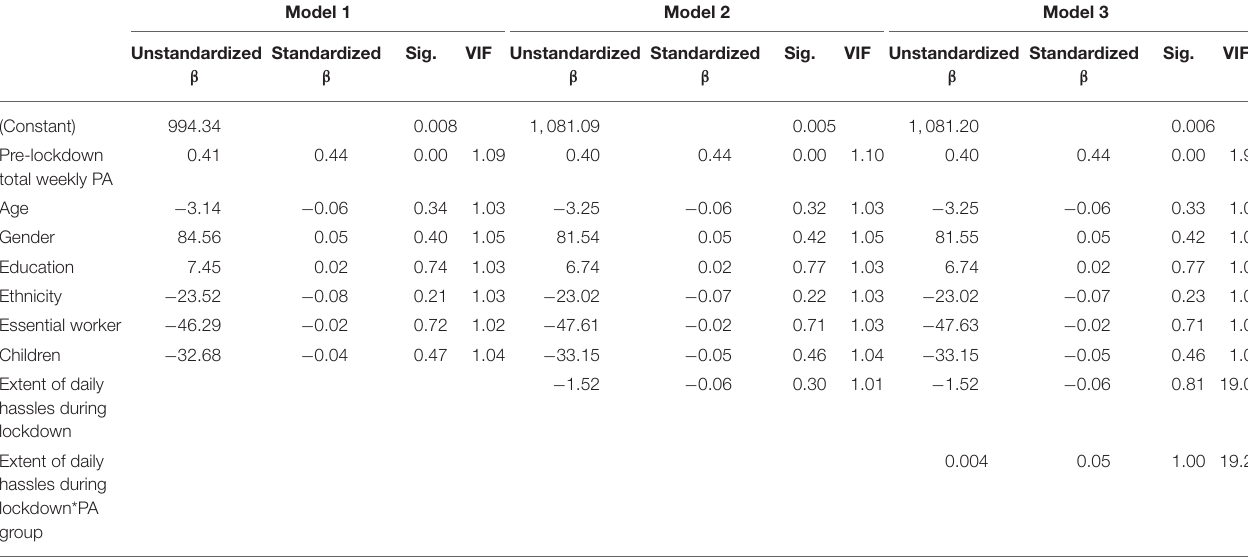
TABLE 4 | Multiple regression results investigating relationships between daily hassles and PA behavior during-lockdown.